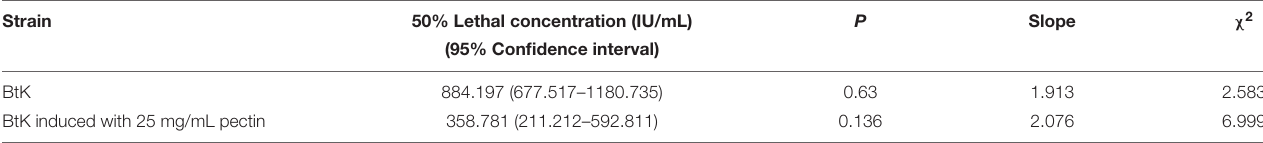
TABLE 4 | Dose/response insecticidal activity of BtK preparation.